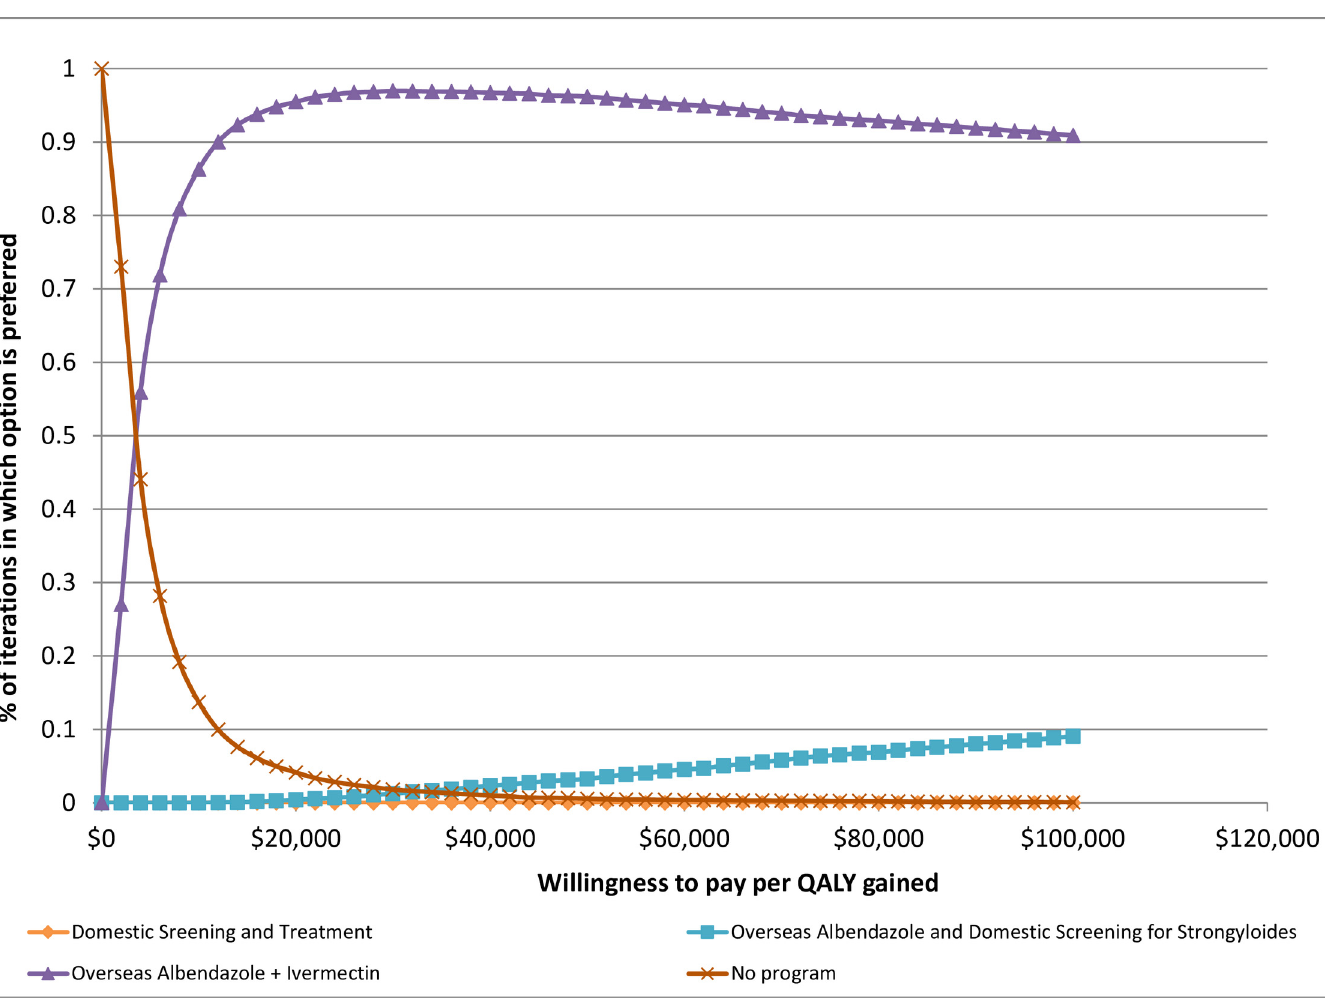
Fig 3. Cost-effectiveness acceptability curve, fraction of Monte Carlo Simulation iterations in which option is preferred as a function of willingness to pay per QALY gained.